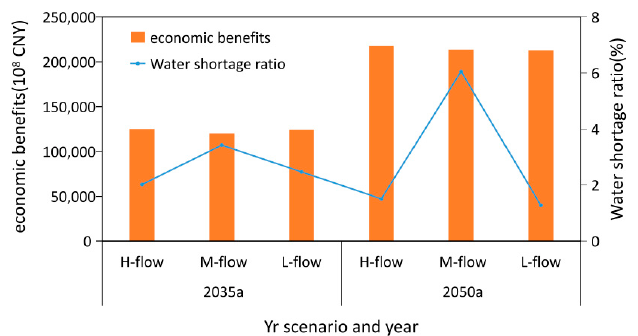
Figure 9. Expected water shortage rates and economic benefits in the Yellow River Basin under different water flow scenarios.